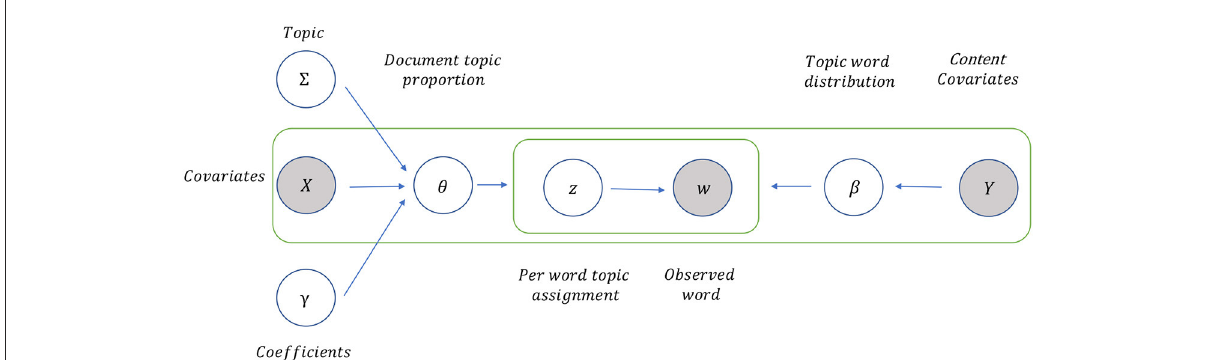
FIGURE3 A graphical illustration of data generative process of structural topic modeling (STM). It assumes that the attributes of document-level metadata can influence the modeling process in terms of topic prevalence (to characterize documents) and topical content (to parameterize the distribution of word occurrences). We consider the covariates of the investor sentiment aggregated at investors’ trading experience, holding strategy, asset category, bullish/bearish sentiment, and posted timestamp. In particular, investors’ trading experience is employed as the covariate in topical content, while other covariates are engaged in topic